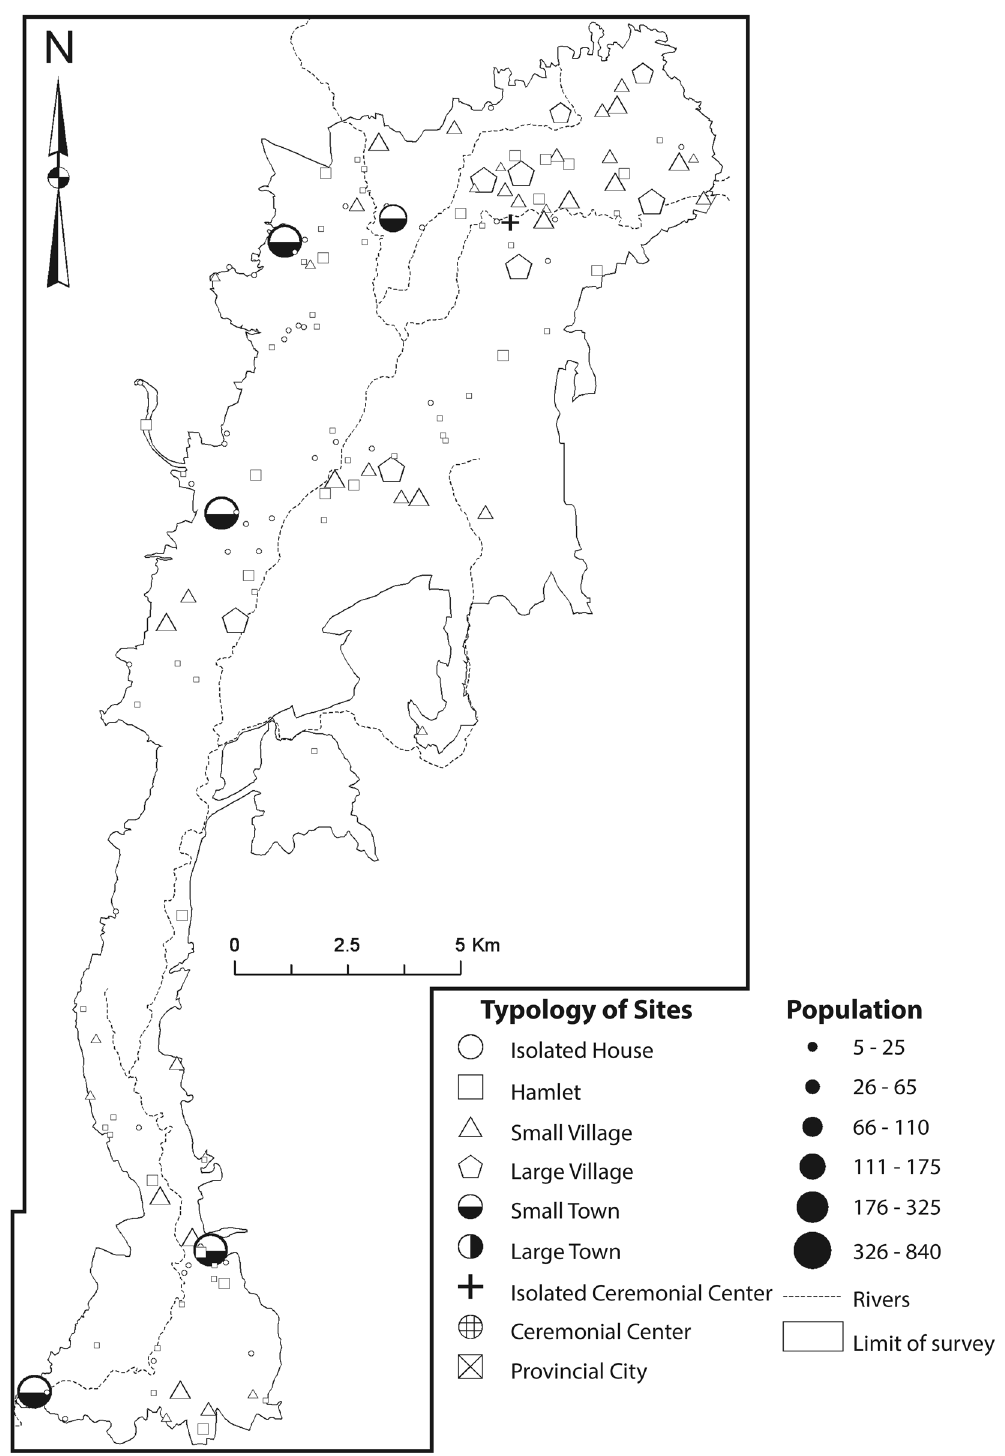
Figure 11: Settlement patterns of the Late Classic